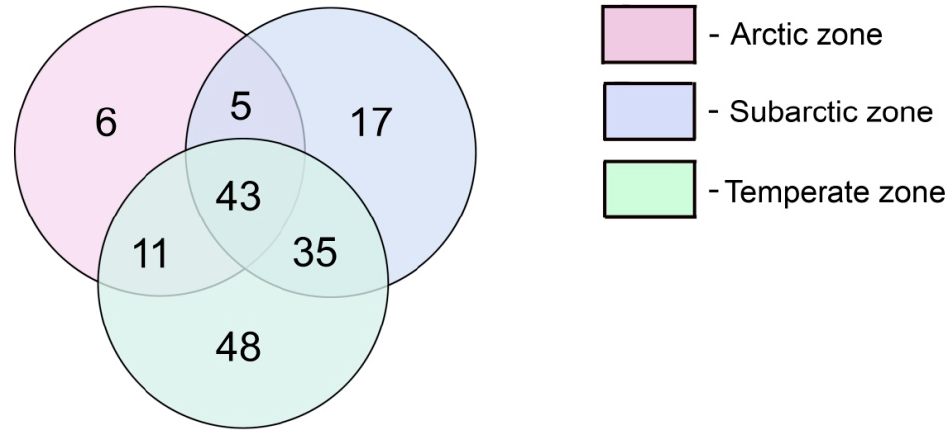
Figure 3. Distribution of 165 species and intraspecific taxa of silica ‐ scaled chrysophytes among the climatic zones (see Figure 2).